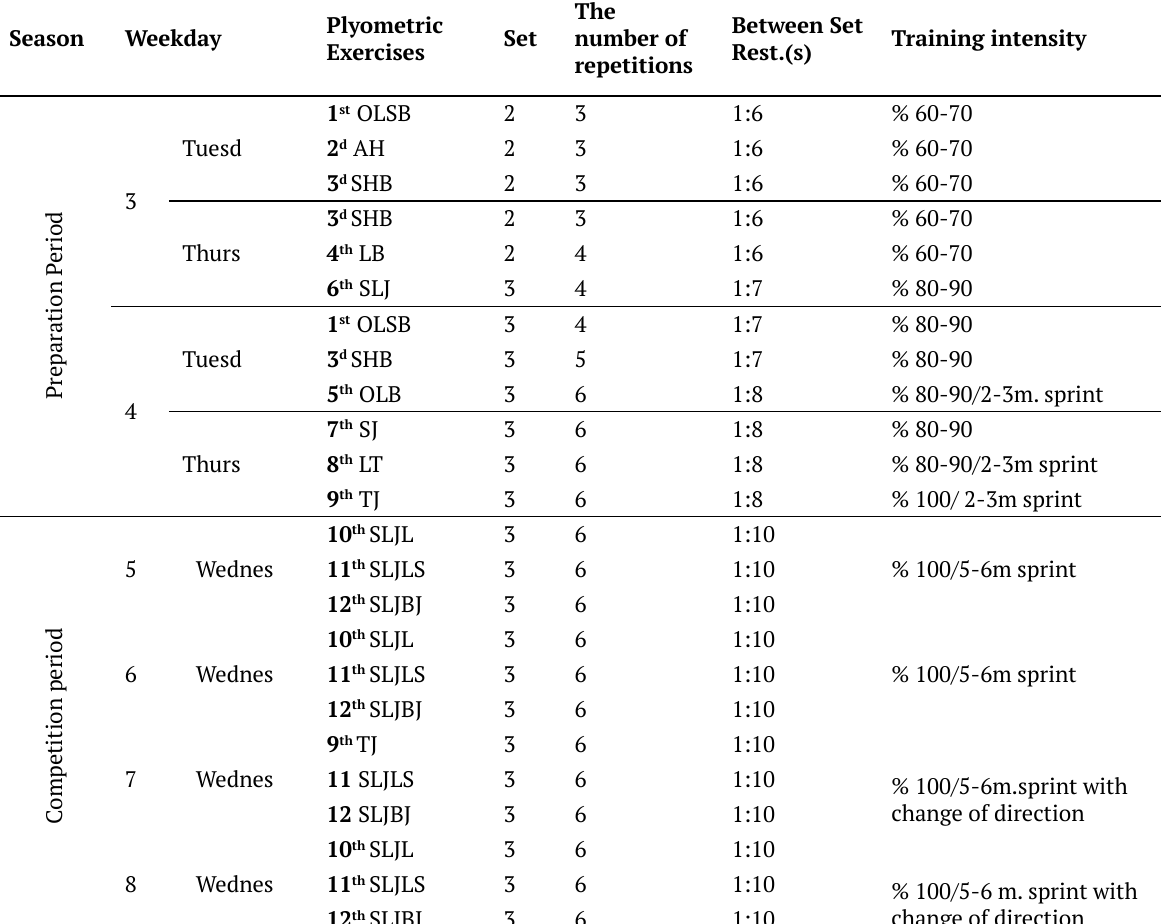
Table 4. Plyometric training